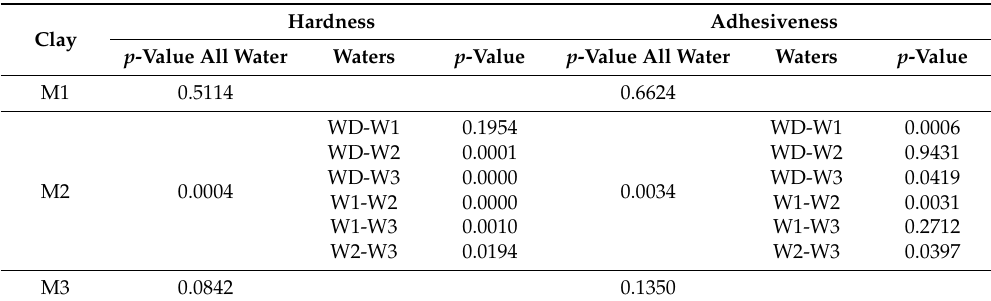
Table 6. The p-values of the statistical test for comparing slope regression lines for hardness (or adhesiveness) by types of clay.